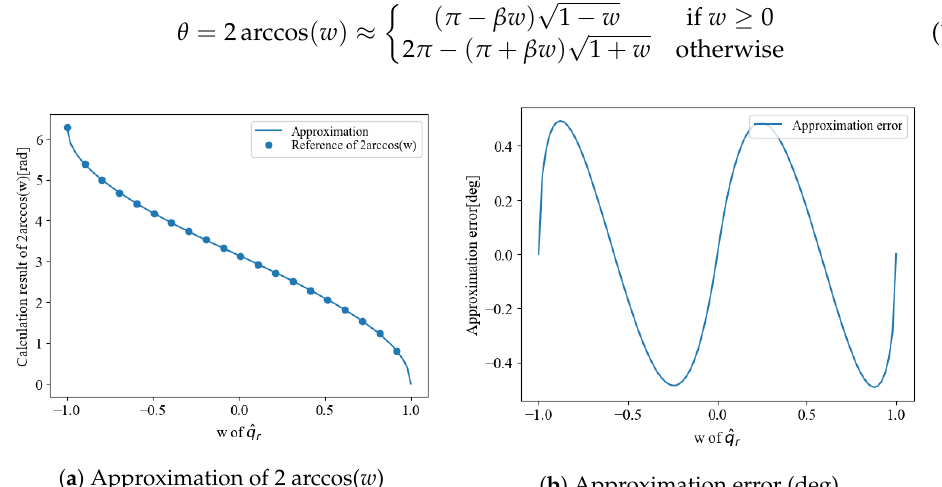
Figure 6. Approximation for fast posture